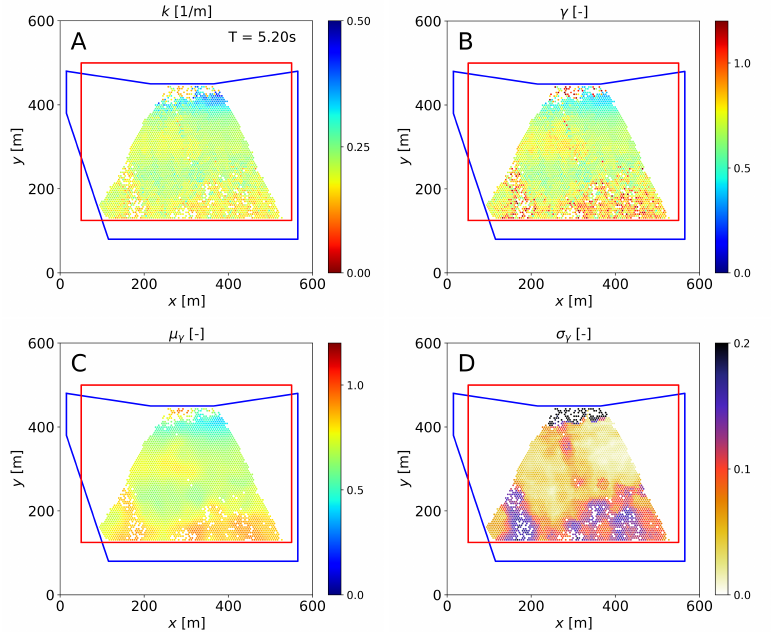
Figure 7. Wavenumber k ( A ), γ ( B ), µ γ ( C ) and σ γ ( D ) obtained from the spatial phases and period in Figure 6A, taking R K the radius of the white circle in the same